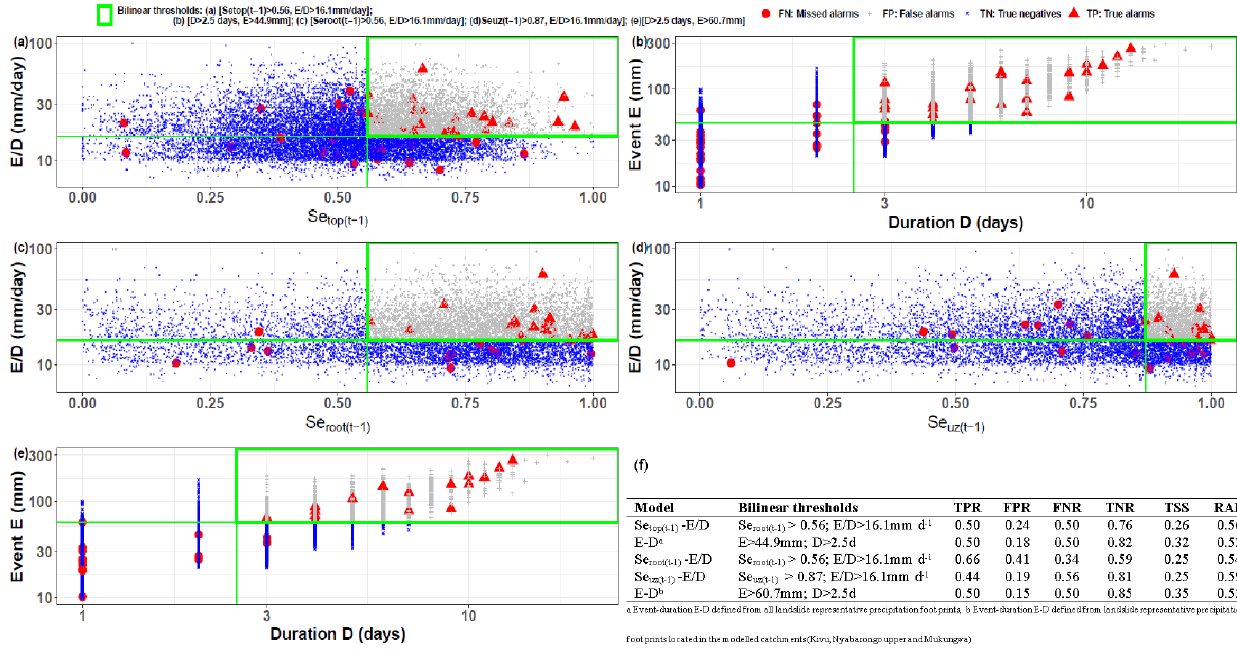
Figure 7. Landslide hydro-meteorological thresholds and prediction capabilities: (a) event intensity antecedent 5cm topsoil moisture thresh- olds (Se top ,t − 1 > 0 . 56 and E/D > 16 . 1mmd − 1 ), (b) E − D thresholds ( D > 2 . 5d and E > 44 . 9mm) defined using precipitation footprints from all landslide locations; (c) event intensity antecedent 50cm topsoil moisture threshold (Se root (t − 1 ) > 0 . 56 and E/D > 16 . 1mm); (d) event intensity antecedent 2m topsoil moisture threshold (Se root (t − 1 ) > 0 . 84 and E/D > 16 . 1mmd − 1 ); (e) E − D thresholds ( E > 60 . 7mm and D > 2 . 5d) defined using precipitation footprints and landslides located in Wflow-modelled catchments; (f) bilinear threshold values and prediction capabilities. Table 5. Cumulative rainfall-based variable thresholds and prediction capabilities. Variables Maximum TSS Minimum Rad